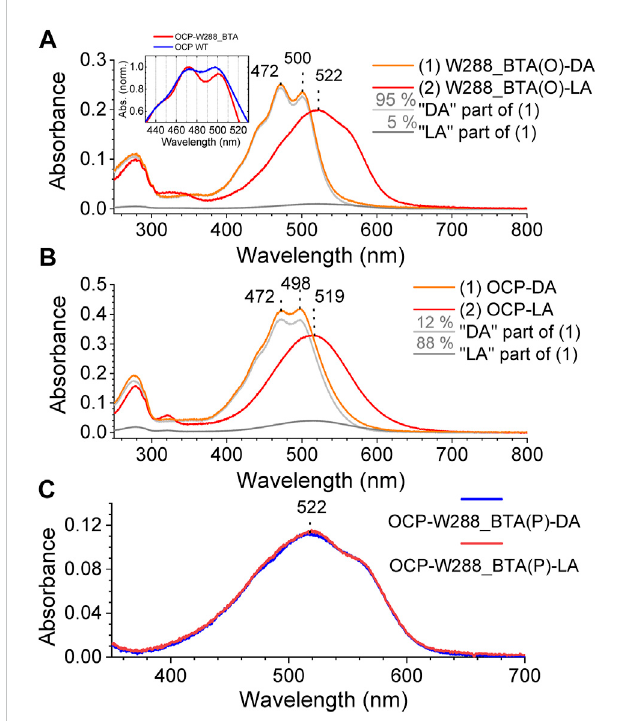
FIGURE 4 Photoswitching of the OCP-W288_BTA(O) and OCP-W288_BTA(P) species. (A) Absorption spectra of the OCP-W288_BTA(O) fraction of the proteininthedark-adapted(DA)andlight-adapted(LA)states(orangeand redcurves, respectively)anddecompositionoftheDAspectruminto 95% orange (light grey) and 5% red (dark grey) spectral components. (B) Absorbance spectra of wild-type OCP in the dark-adapted (DA) and light- adapted (LA) states (orange and red curves, respectively) and decomposition of the DA spectrum into 88% orange (light grey) and 12% red (dark grey) spectral components. The inset in (A) shows the spectra of OCP wild-type and OCP-W288_BTA(O) at higher magni fi cation. (C) Absorption spectra of the pink fraction of OCP-W288_BTA protein in the dark-adapted (DA) state (magenta) and after 5 min illumination (LA) with blue light